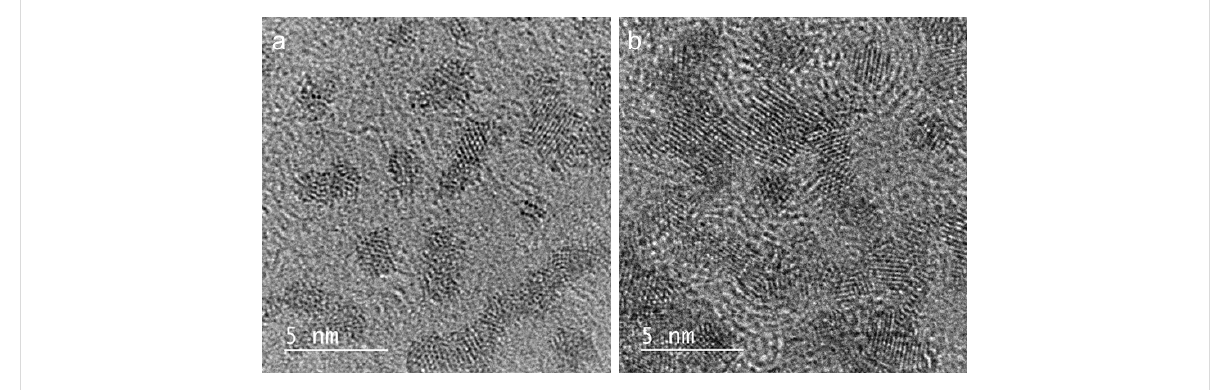
Figure 2: HRTEM images of C-dots obtained by carbonization in NaOH 30% (w/v), using as carbon source a) carrots, b) tree leaves.